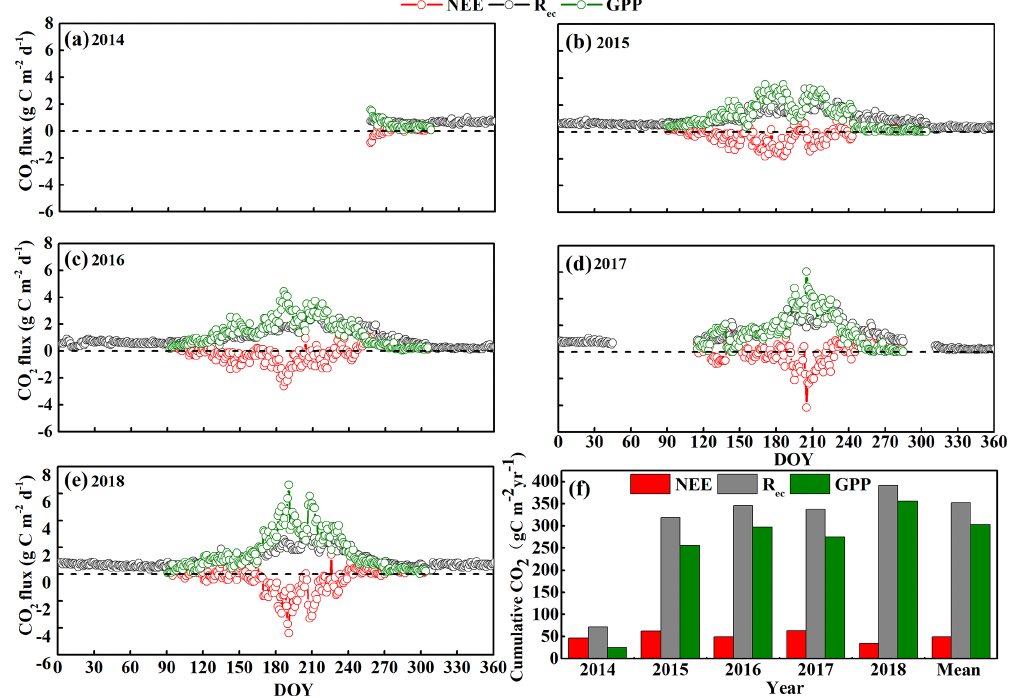
Figure 3. Seasonal and inter-annual variation in the daily average net ecosystem CO 2 exchange (NEE), gross primary productivity (GPP), and ecosystem respiration ( R ec ) from (a–e) 2014 to 2018 by day of year (DOY). (f) Annual cumulative NEE, GPP, and R ec from 2014 to 2018. Positive NEE values indicate net CO 2 release, whereas negative values indicate net CO 2 uptake by the ecosystem. Note that the initial measurements were from 15 September to 23 December 2014, so no data are available for the first part of